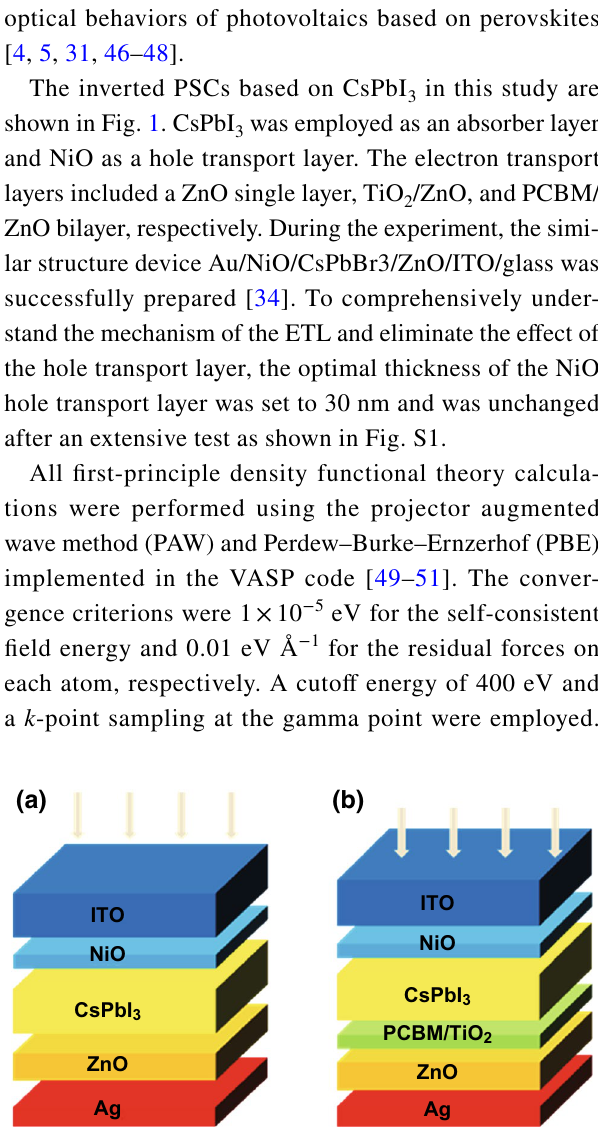
Fig. 1 Schematic device structure of the CsPbI 3 -based PSCs with a ZnO single-layer and b TiO 2 (PCBM)/ZnO bilayer